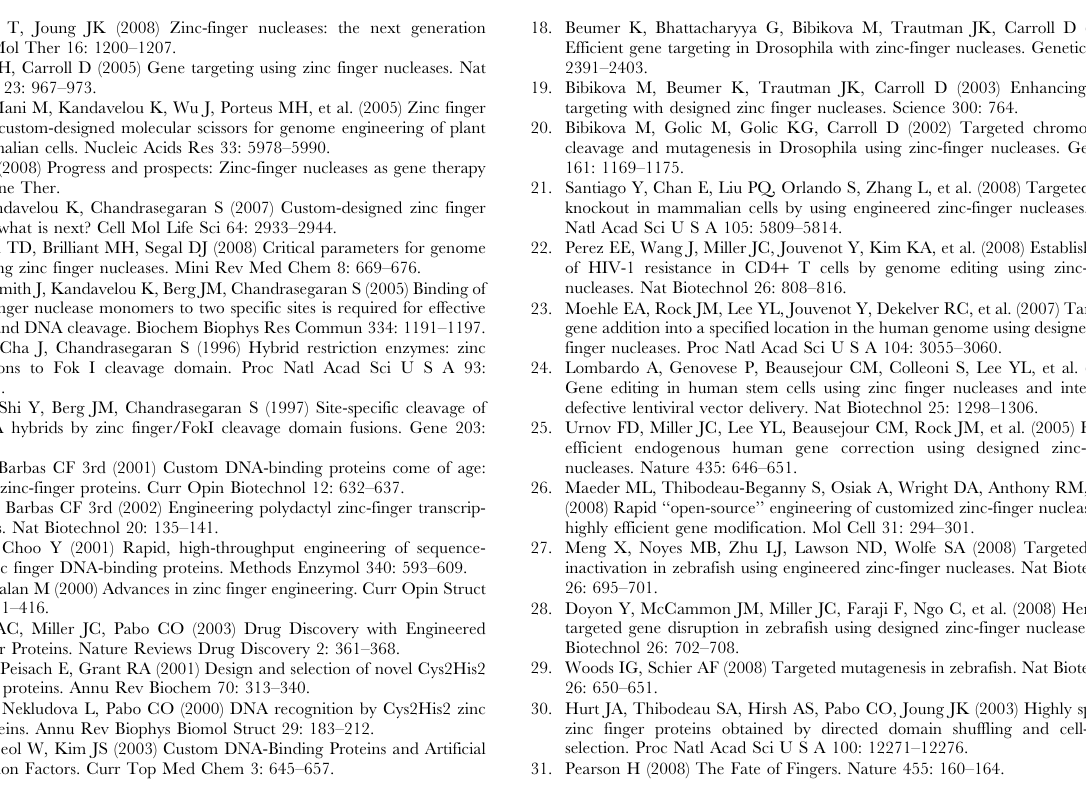
Table S25 Potential OPEN ZFN target sites in gene transcripts encoded on zebrafish chromosome 25. Data presented as described in the legend to Table S1.